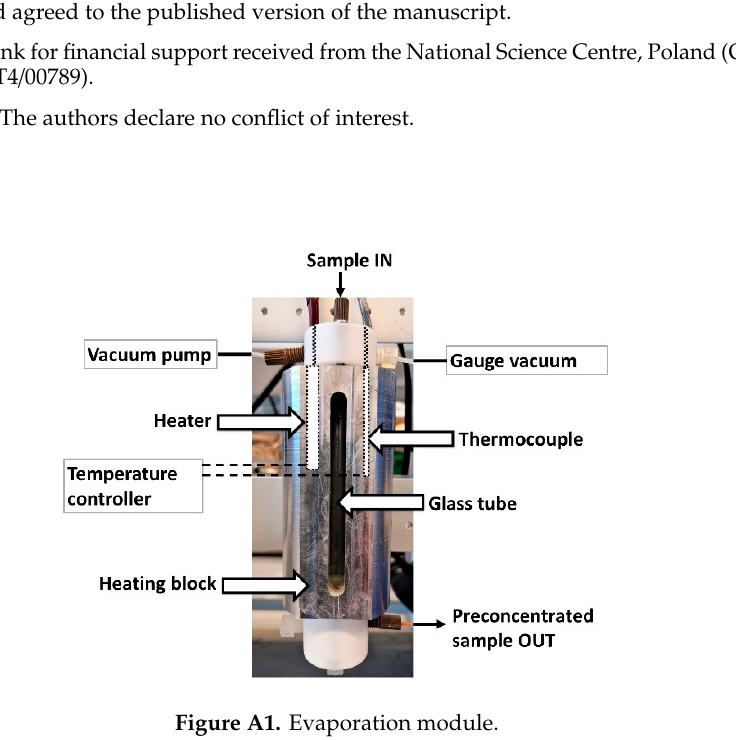
Figure A1. Evaporation module.